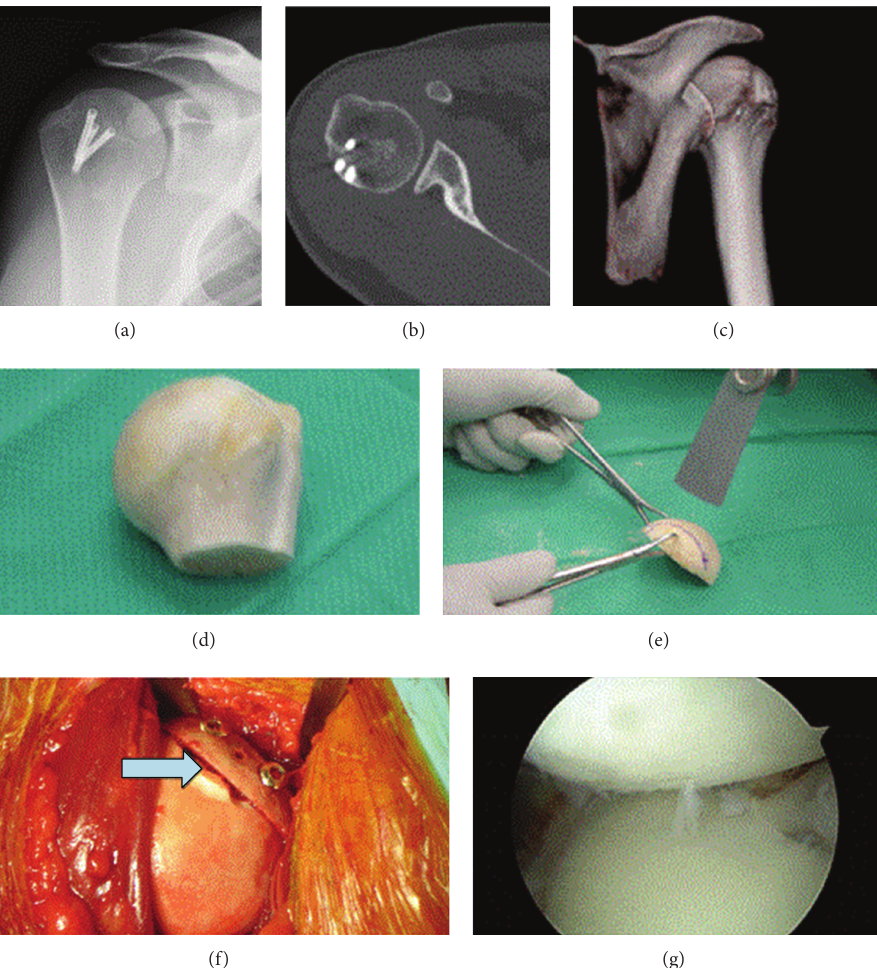
Figure 5: Postoperative (a) radiographic and (b)-(c) CT images following osteochondral allograft transplantation to the humeral head for a large Hill-Sachs lesion. Intraoperative pictures showcase the procured humeral head allograft (d), sizing of the graft (e), and in situ graft fixation on the humeral head (f). (g) Arthroscopic evaluation of the incorporated graft at second look arthroscopy.